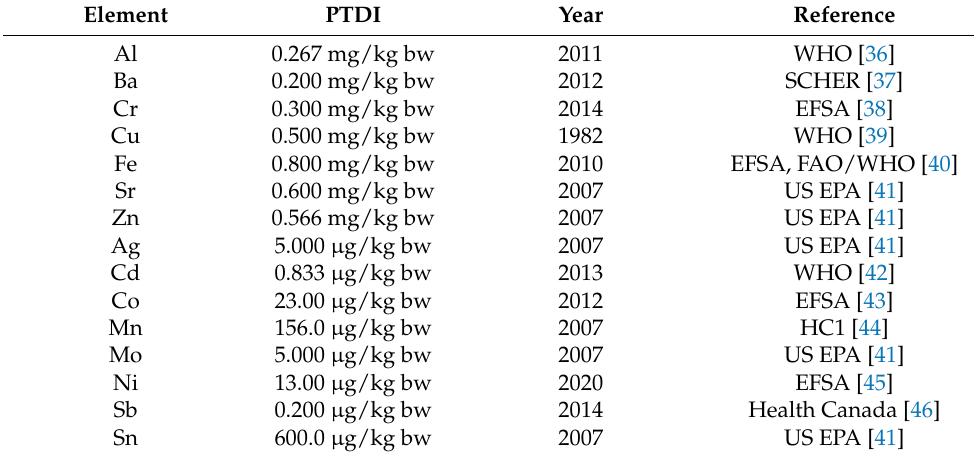
Table 8. Provisional tolerable daily intake (PTDI) for chosen elements [36–46]. Element PTDI